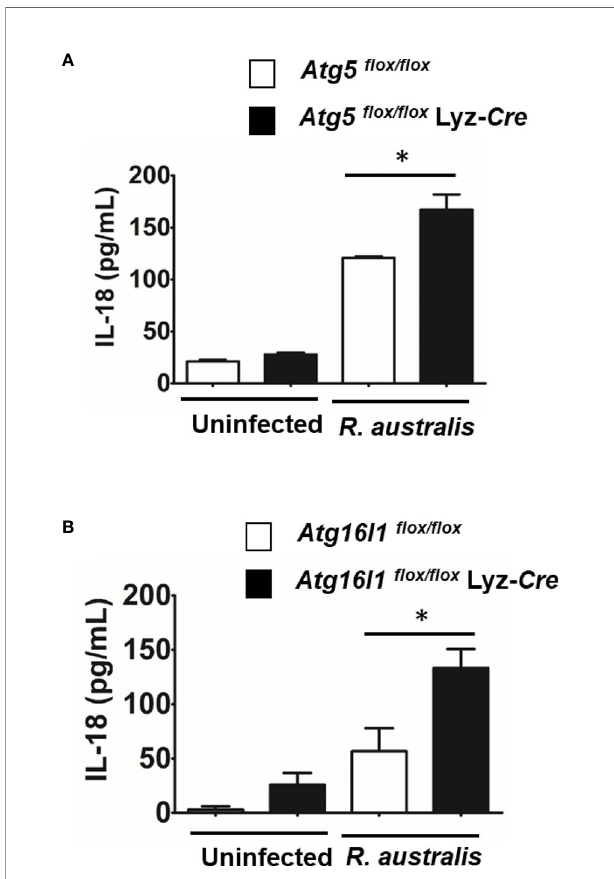
FIGURE 5 | (previous Figure 5). R. australis suppressed the production of IL- 18 by infected macrophages via Atg5 -dependent autophagy. BMMs were isolated from Atg5 fl ox/ fl ox Lyz- Cre and Atg5 fl ox/ fl ox mice, and Atg16l1 fl ox/ fl ox Lyz- Cre and Atg16l1 fl ox/ fl ox mice. Macrophages were infected with R. australis at an MOI of 5. At 24 h p.i., supernatant was harvested. Concentrations of IL-18 in the supernatant of infected Atg5 fl ox/ fl ox Lyz- Cre BMMs and Atg5 fl ox/ fl ox BMMs (A) , and infected Atg16l1 fl ox/ fl ox Lyz- Cre BMMs and Atg16l1 fl ox/ fl ox BMMs (B) were assessed by ELISA. Results are means ± SE of data from two independent experiments. * p <